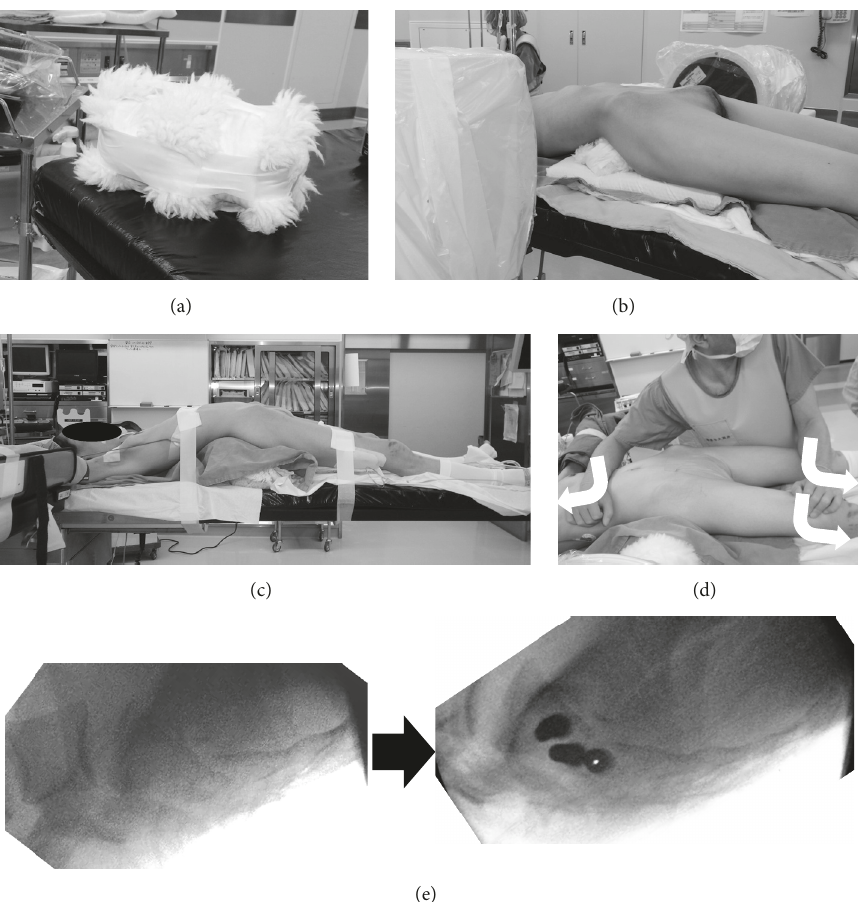
Figure 1: Closed reduction procedure in “hyperextended” supine position with manipulation. (a) A hand-made reduction pillow is shown. (b) The intraoperative position and “hyperextended” supine position is shown. (c) The manipulation maneuver is shown. (d) Intraoperative images are shown. The left image was taken before reduction maneuver and the right image was taken after the maneuvers. If good reduction was obtained, screw insertion was done in the same position. (e) Intraoperative fluoroscopic images pre- and postreduction maneuver. In this case, good reduction was